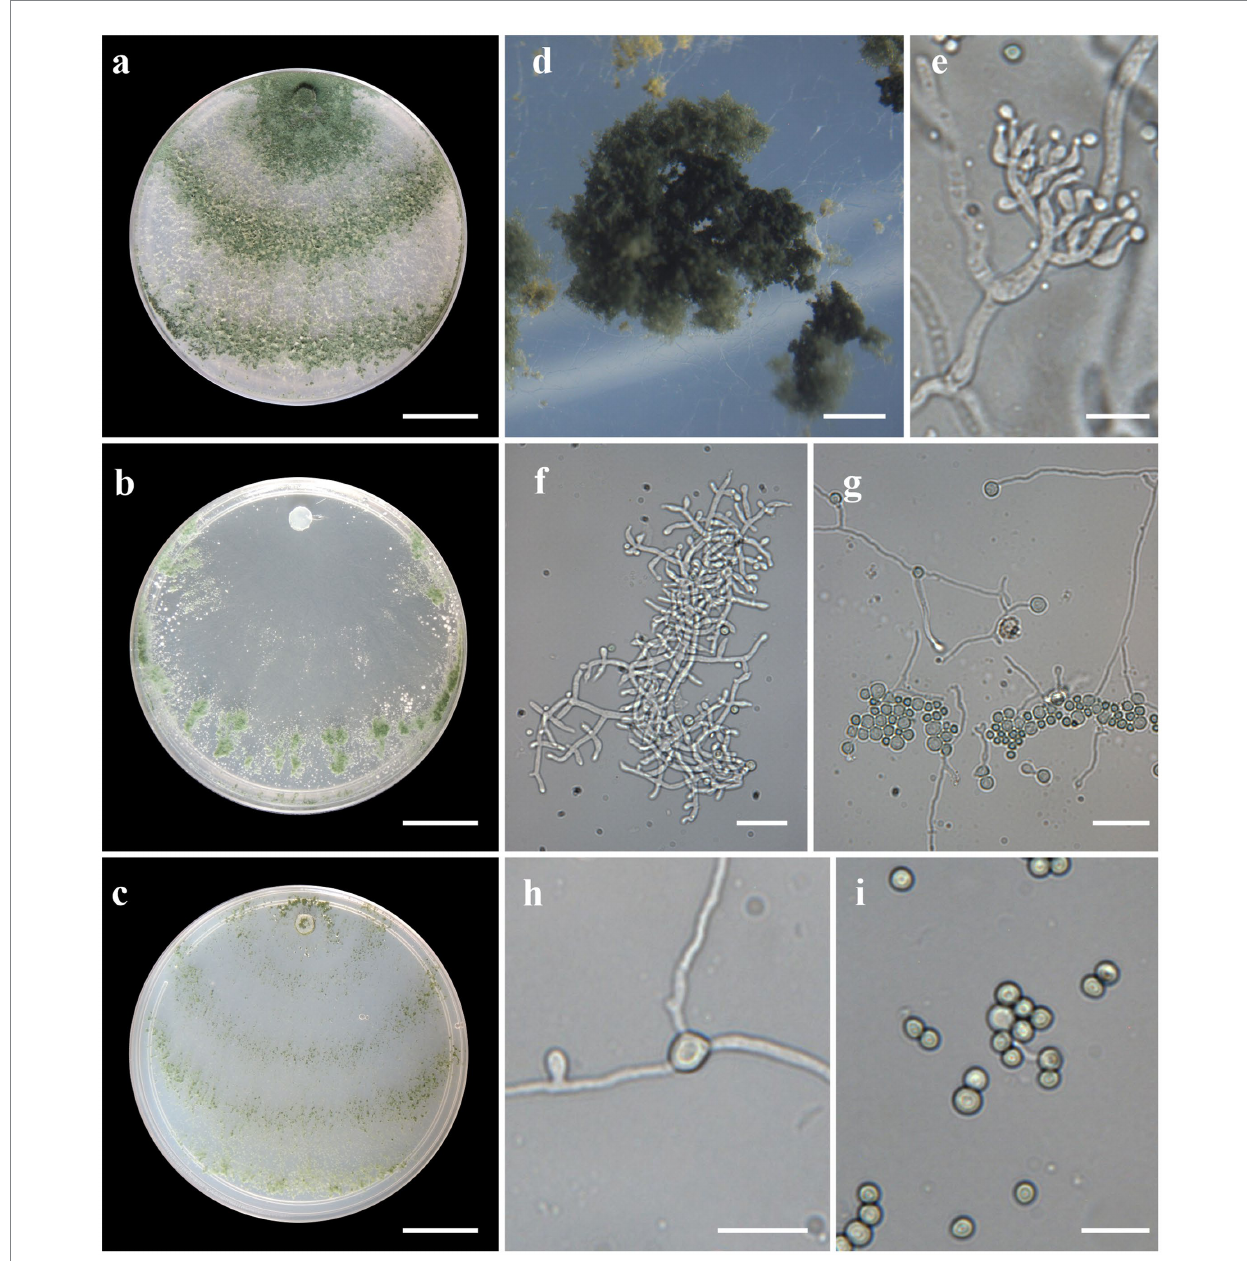
FIGURE 6 Asexual morph of Trichoderma heveae sp. nov. from Hevea spp. (VIC44362, holotype). ( A–C ) Colony appearances (PDA, CMD, and SNA; 7 days, 25 ° C). ( D ) Sporulating pustules (SNA). ( E,F ) Conidiophores and phialides (SNA). ( G , H ) Chlamydospores. ( I ) Conidia. Scale bars: ( A–C ) 20 mm, ( D ) 0.5 mm, ( E , I ) 10 μ m, and ( F–H ) 20 μ